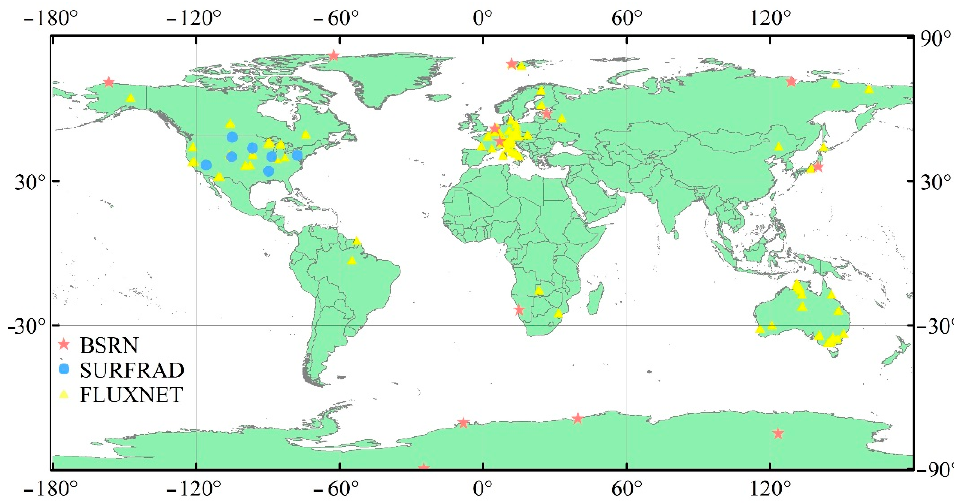
Figure 1. Geographical distribution of the observation